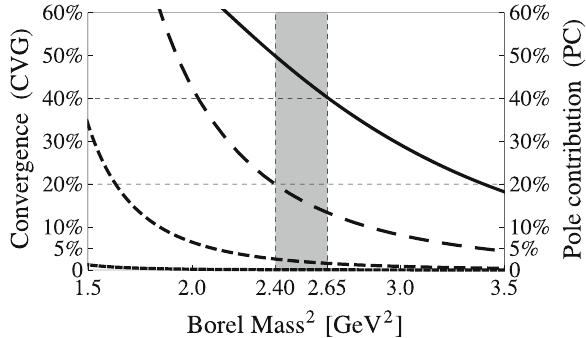
After parameterizing the spectral density ρ ii ( s ) as one pole